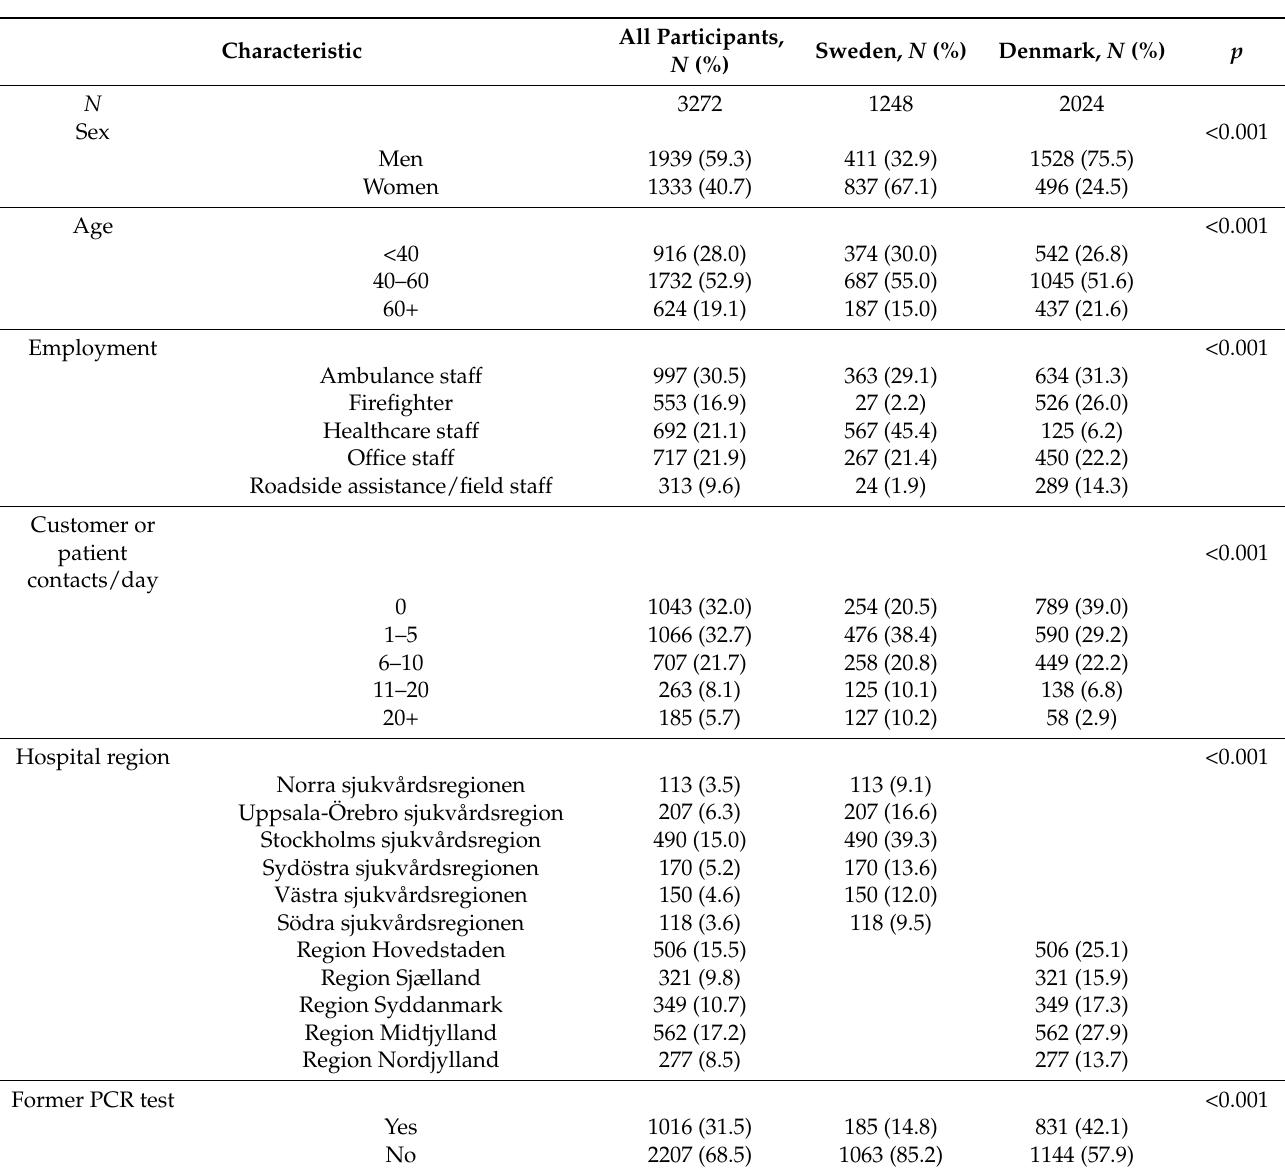
Table 1. Description of the cohorts in Sweden and Denmark. These descriptions represent the first test for each employee.